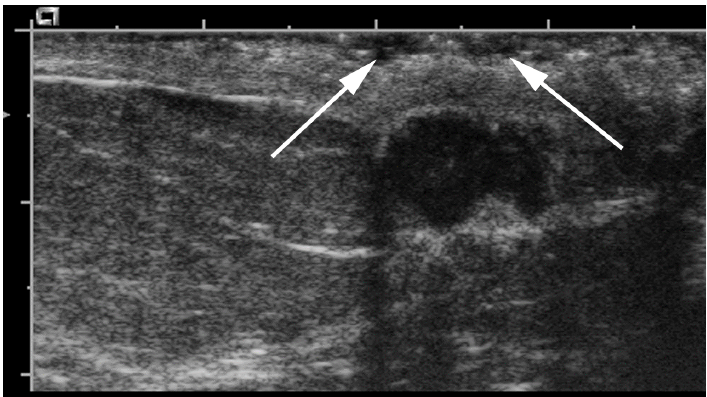
Figure 6. US images of a highly suspicious retroareolar mass after a thick pad of gel in a 56-year-old patient (arrows). US-guided core needle biopsy demonstrated invasive ductal carcinoma.